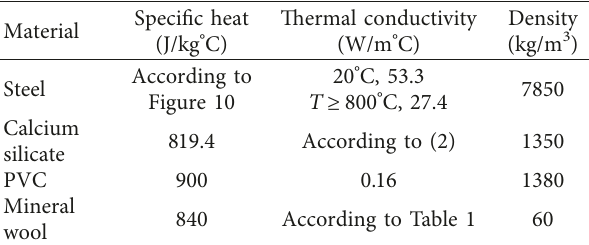
Table 2: Thermal properties.